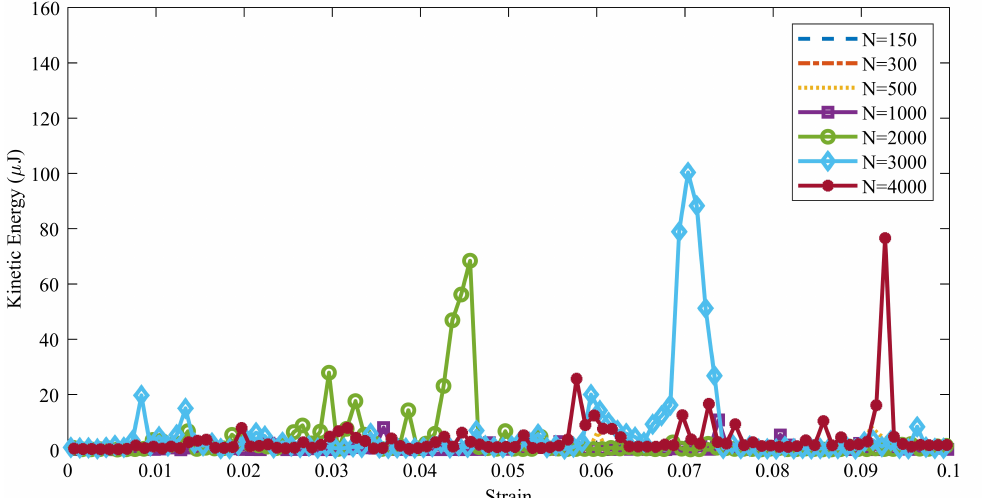
Figure 12. The evolution of the total kinetic energy of different RVEs during the compaction